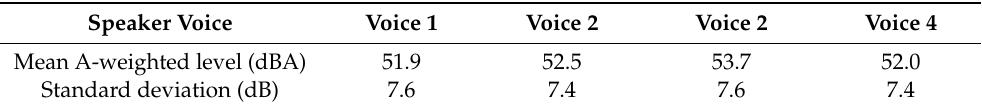
Table 6. Marginal means and standard deviations of the groups at four different levels of speaker voice in the listening part of the